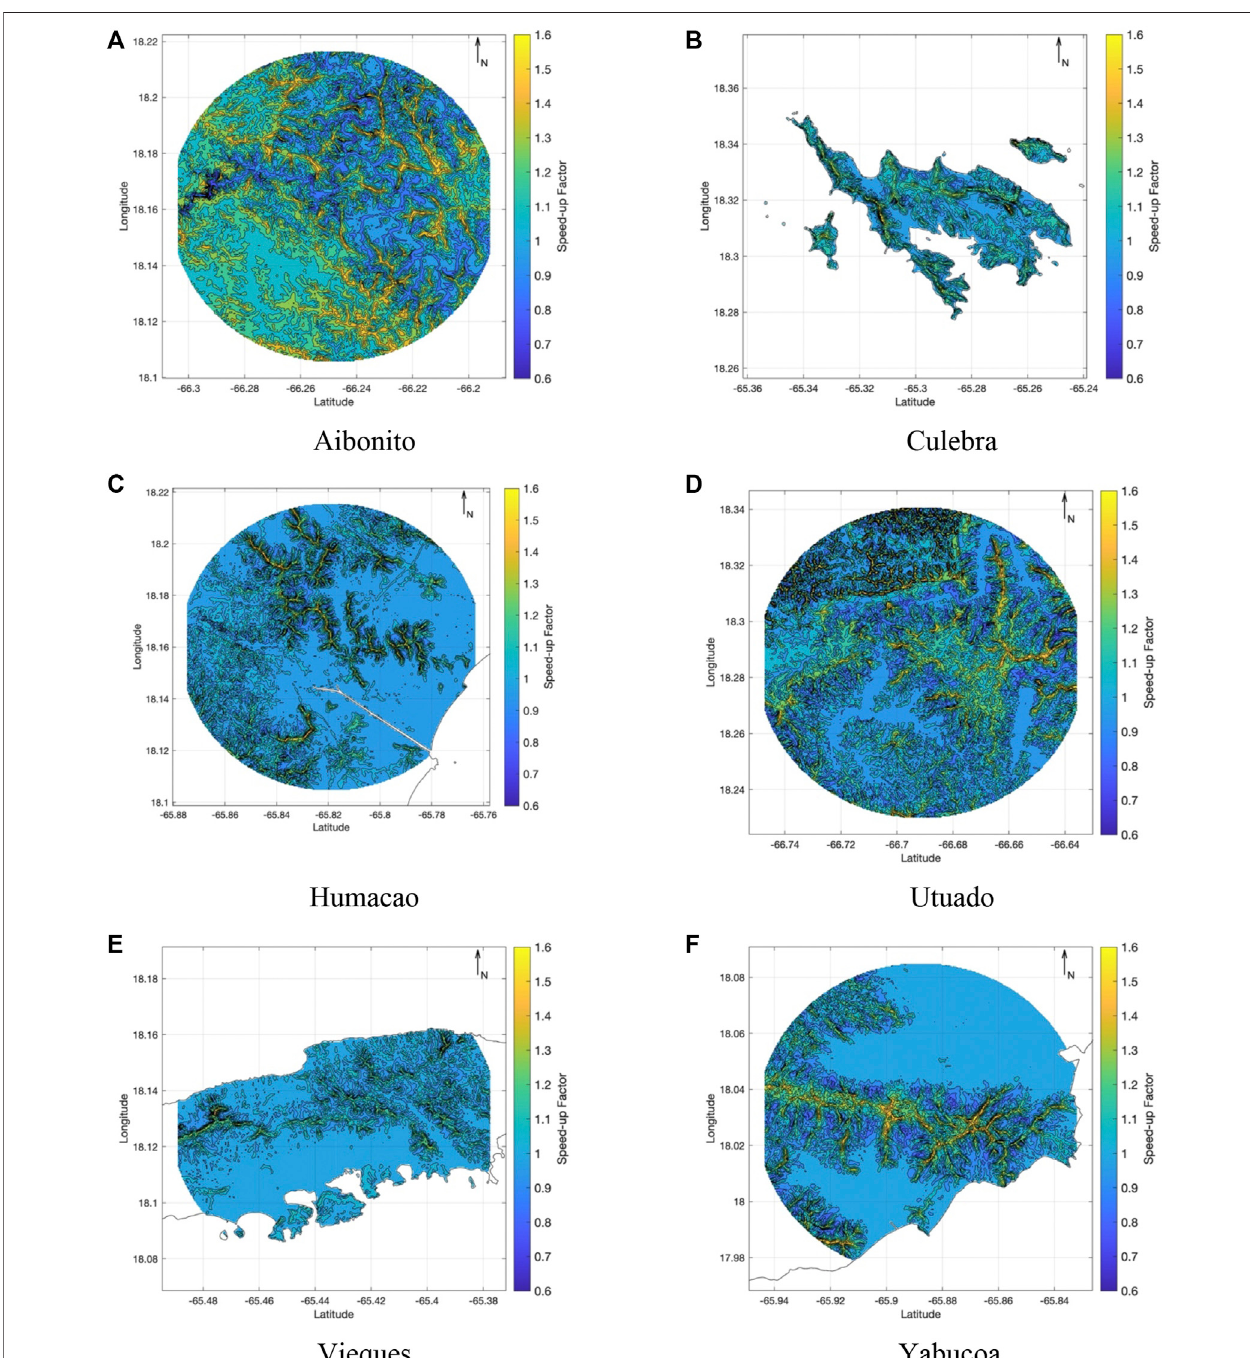
FIGURE 15 | Predictions of topographic effect multipliers, enveloping for all directions. (A) Aibonito. (B) Culebra. (C) Humacao. (D) Utuado. (E) Vieques. (F) Yabucoa.